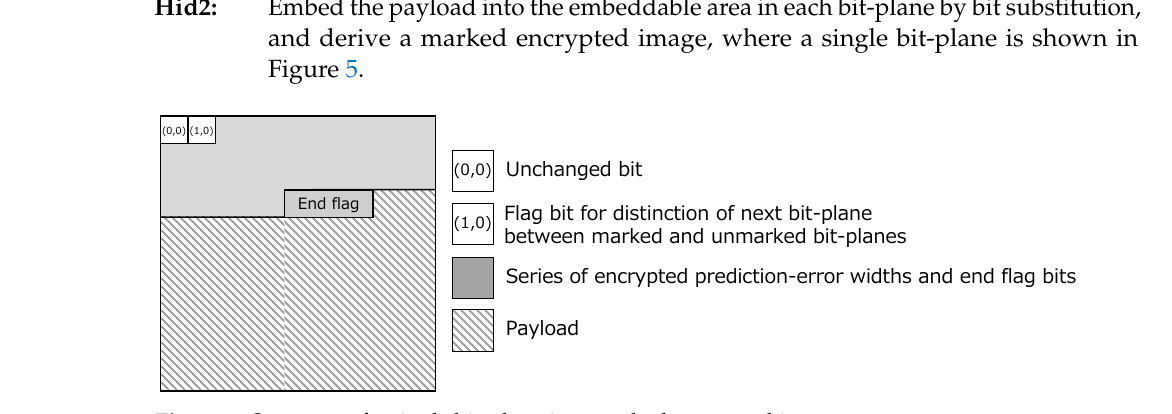
Figure 5. Structure of a single bit-plane in a marked encrypted